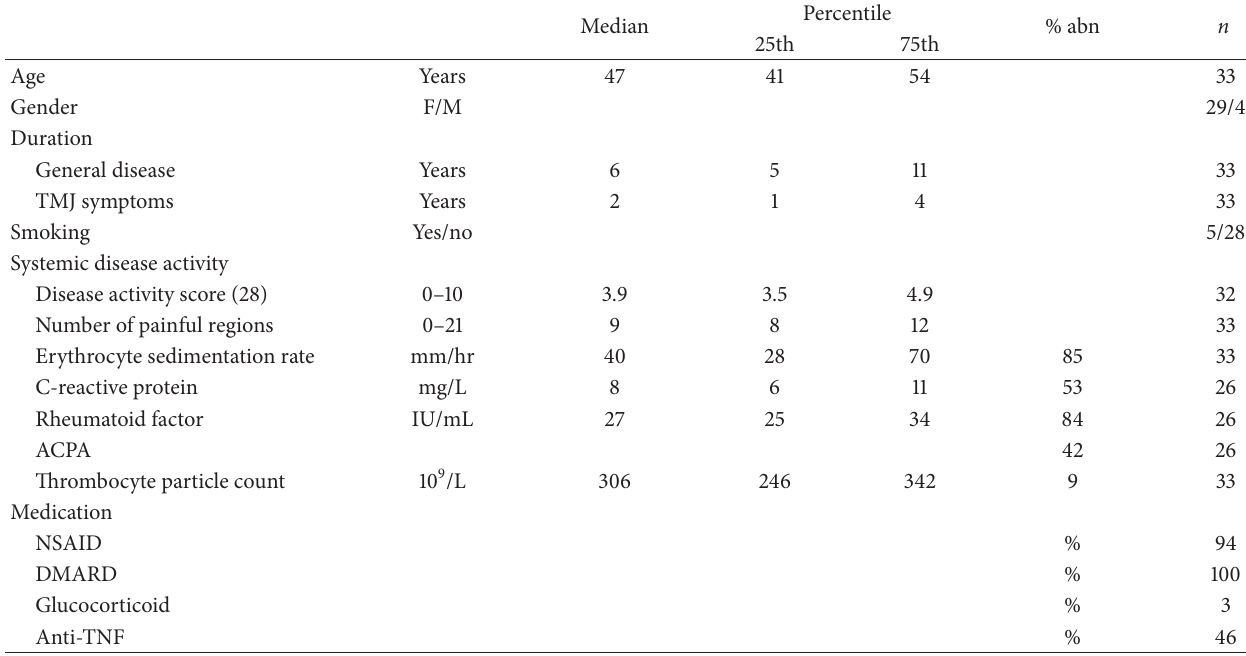
Table 1: Demographic and background data for 33 patients with temporomandibular joint (TMJ) involvement of rheumatoid